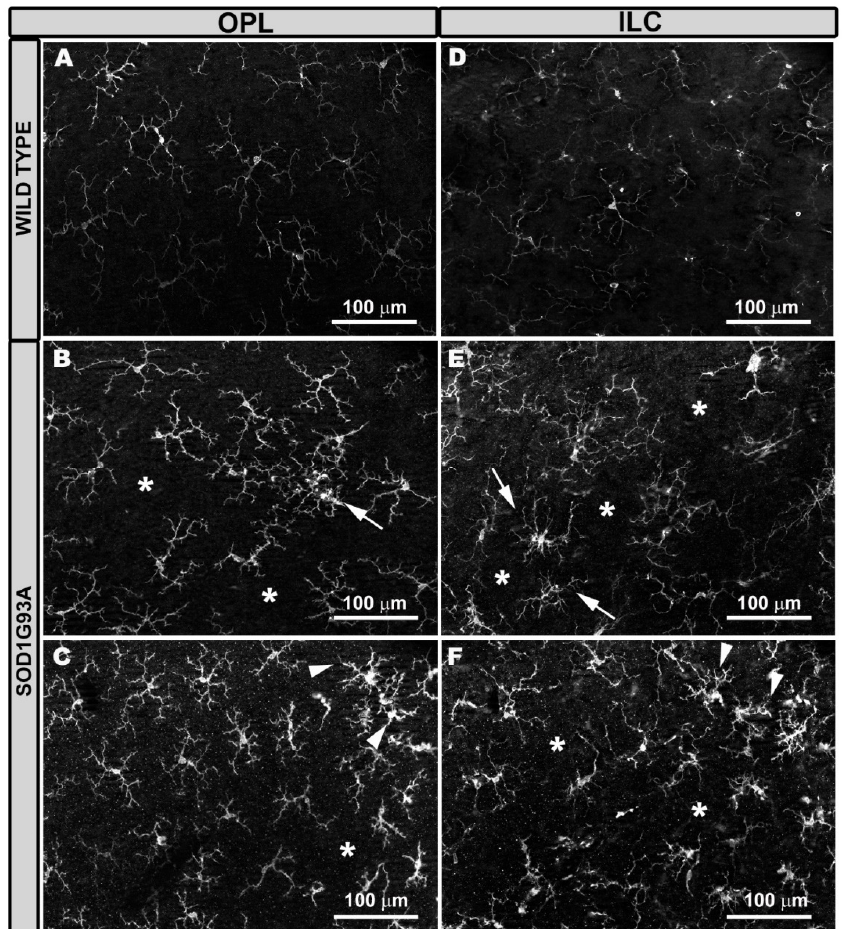
Figure 2. Microglial cells in the outer plexiform layer (OPL) and inner layer complex (ILC) constituted by the inner plexiform layer and nerve fiber layer–ganglion cell layer. Retinal whole-mount labeled with anti-Iba-1. Compared to wild type mice ( A,D ), in SOD1G93A mice the microglial plexus was not as regular in OPL ( B , C ) and in ILC ( E , F ). There were areas where the microglia grouped together and featured retracted processes, leaving areas without cells (*). The groups of cells were formed either in circles ( B , E ) (arrows) or in rows ( C , F ) (arrowheads). Number of retinas used in the experiment, WT: n = 6; and SOD1G93A: n = 6.